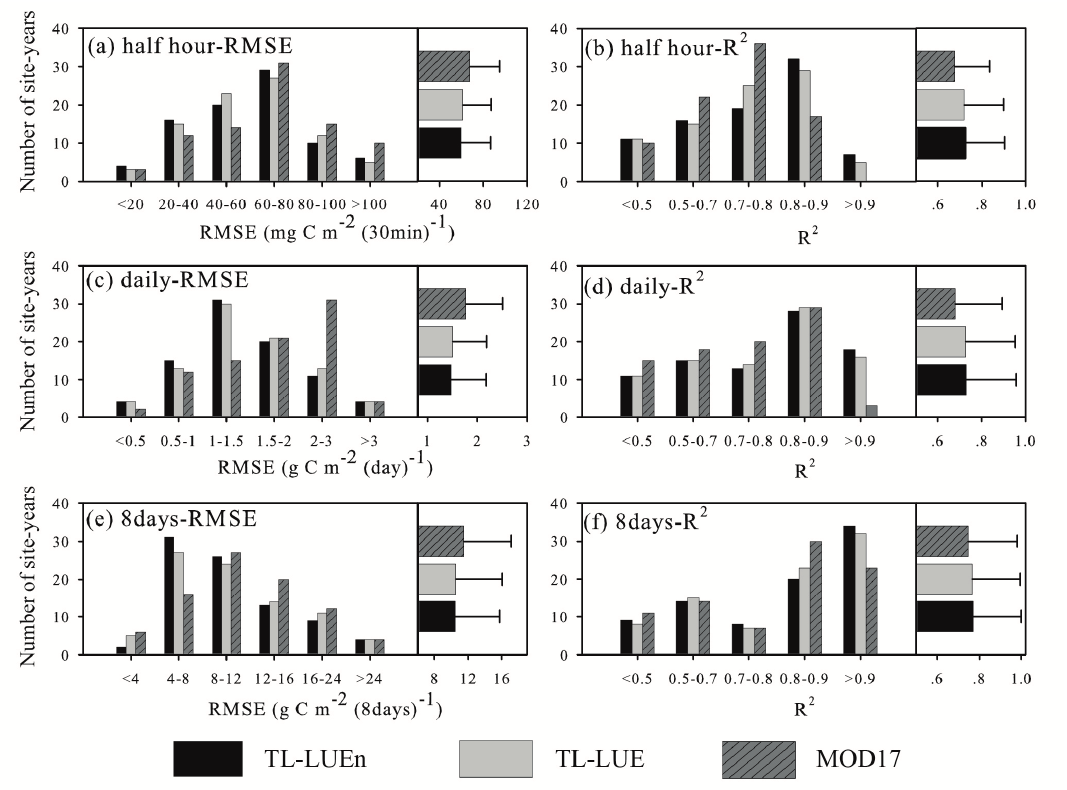
Figure 2. The number of site-years within different root mean square error (RMSE) and R 2 classes ( left ) and the averages of RMSE and R 2 ( right ) of GPP simulated using the TL- LUEn, TL-LUE, and MOD17 models in 85 calibration site-years at half-hourly ( a , b ), daily ( c , d ), and 8-day ( e , f ) temporal scales,